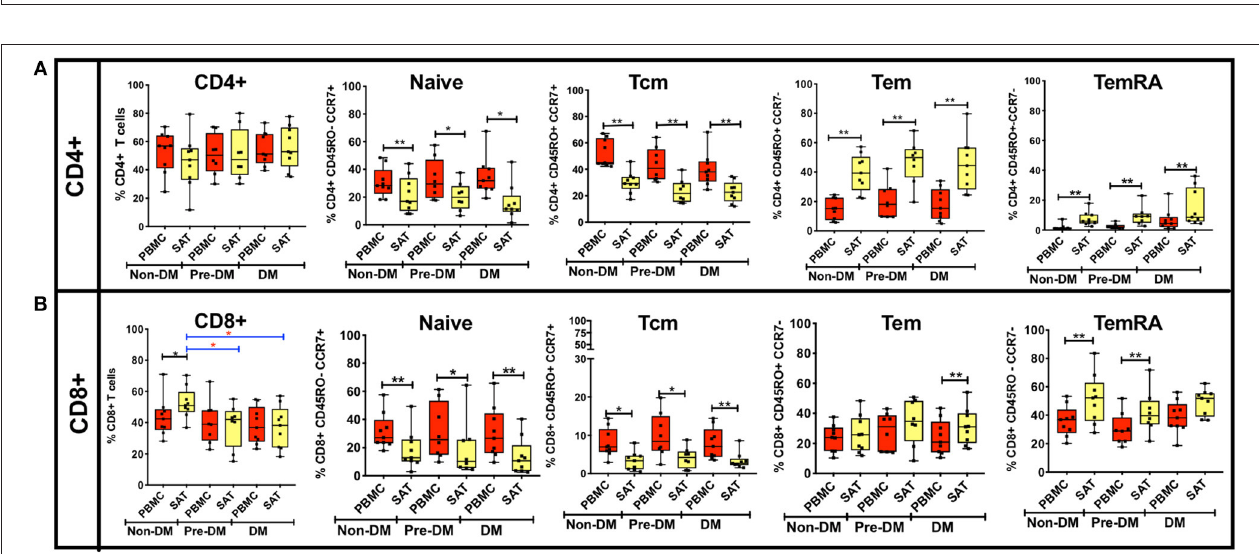
FIGURE 2 | Subcutaneous adipose tissue has a higher percentage of T EM (CD45RO + CCR7 − ) and T EMRA (CD45RO − CCR7 − ) cells compared to blood in PLWH. (A) The bar graphs show frequencies of CD4 + T Nai , T EM , T CM , and T EMRA cells in subcutaneous adipose tissue (SAT) and blood (PBMC) from all twenty-six subjects. (B) Frequencies of CD8 + T Nai , T EM , T CM , and T EMRA cells in SAT and PBMC. The numbers in the bar graphs on the left indicate mean and diagonal lines indicate matched pairs of SAT and PBMCs. Wilcoxon matched pair signed test was used to calculate statistics **** p < 0.0001; *** p < 0.001.